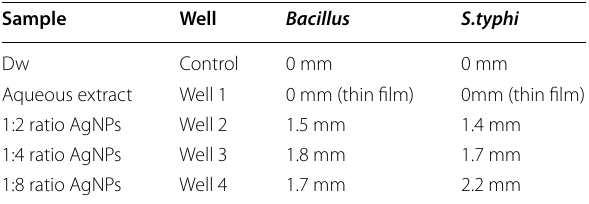
Table 3 Showing the diameters of the inhibition zone in bacterial